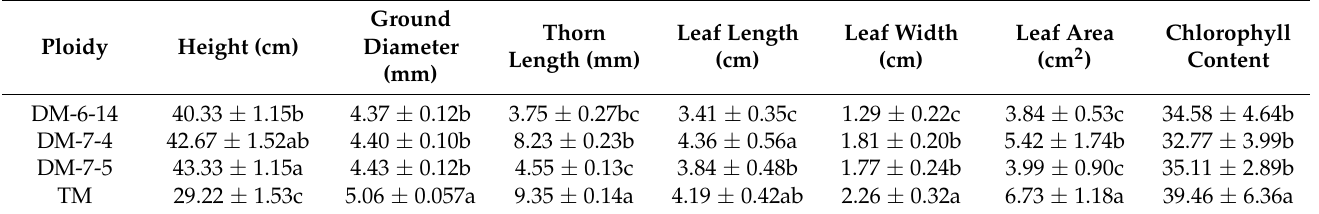
Table 6. Comparison of phenotypic traits between diploid and triploid plants.